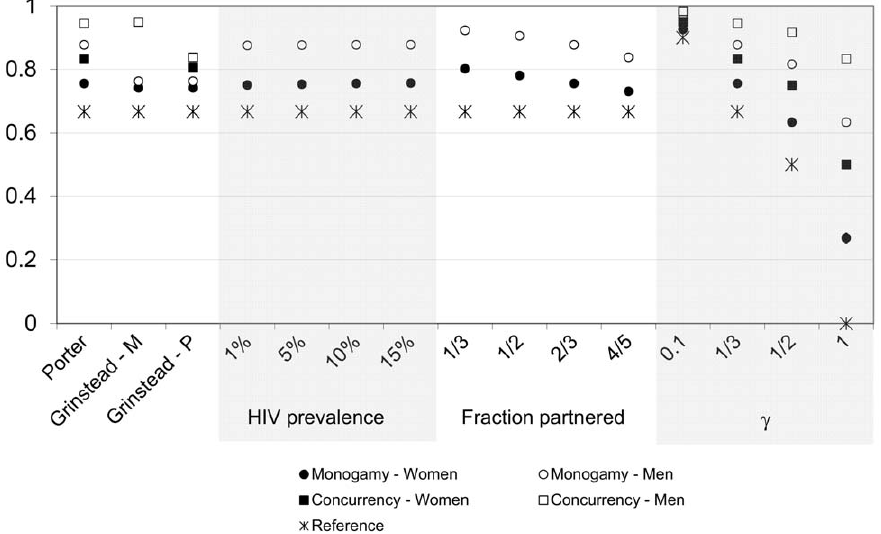
Figure 3. Sensitivity analysis: relative percentage decline in new HIV infections for each percentage point increase in HIV status awareness. Notes: Grinstead – M=Marriages; Grinstead – P=sexual partnerships. The reference scenario only accounts for behavioral adjustments to limit transmission within serodiscordant couples ( c =1/3); the other scenarios demonstrate the total effect of HTC through both behavior change and partnership dissolution. The estimate of the effect of HTC for females in the concurrency model with the parameters for marriages from Grinstead et al. is not shown because no F-M + marriages dissolved in that study, leading to a division by zero in our calculations. The actual percent decline in new infections varied slightly with HIV testing coverage but is always within 0.02 of the value shown. The first scenario of panel 1, the third scenario of panel 2, the third scenario of panel 3 and the second scenario of panel 4 are the baseline scenario and are thus identical. The concurrency model is not dependent on HIV prevalence or the fraction partnered and its estimates have been omitted for those scenarios.